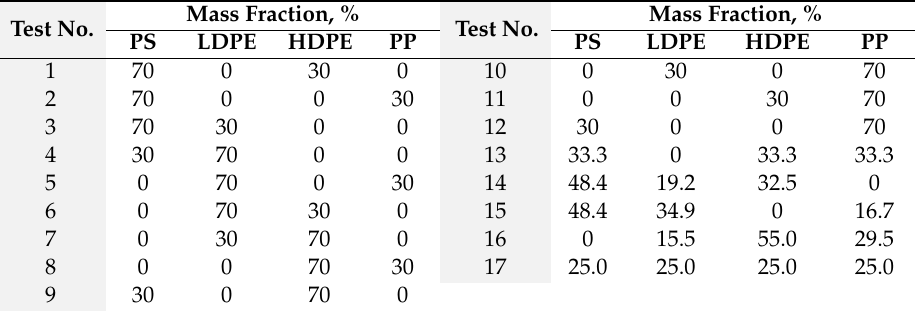
Table 2. Polymers compositions of the experimental